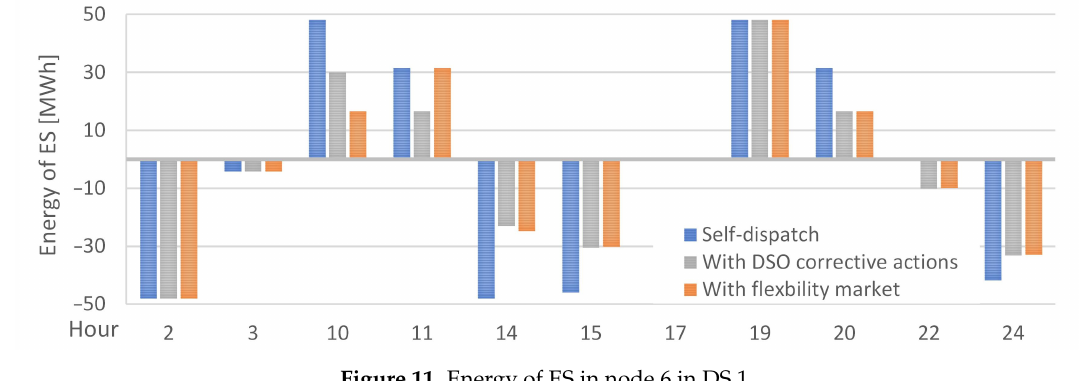
Figure 11. Energy of ES in node 6 in DS 1.